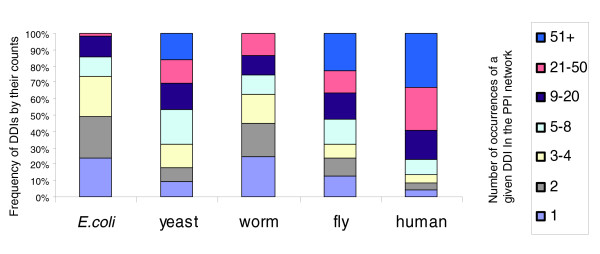
Repeated use of interacting domain-pairs in PPI networks. For each organism, the number of occurrences of each DDI in the PPI network was counted. The histogram shows the frequency of PPIs that were attributed to DDIs used only once, twice, and so on. The frequency is computed out of all the PPI-DDI mappings. DDI, domain-domain interaction; PPI, protein-protein interaction.